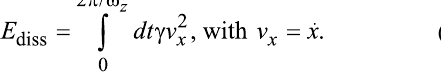
For the lateral excitations we include a viscous friction term with the coefficient γ , because these losses are not compensated like they are in the bending mode. Commonly, γ is expressed by the quality factor Q = ( m x ω x )/ γ , where . We only consider damping in the lateral degree of freedom and therefore omit any sort of indexing of damping parameters (such as Q x